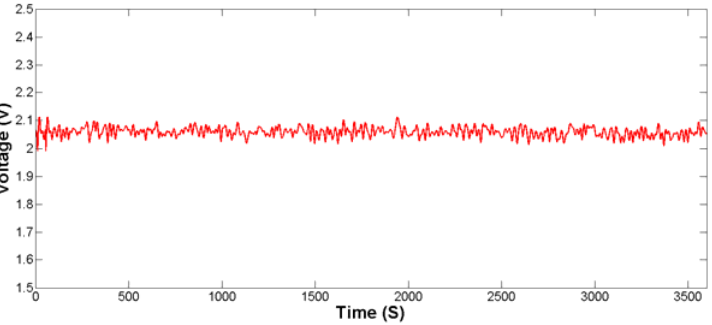
Figure 13. The creep of the designed plantar force sensor for 1 h.